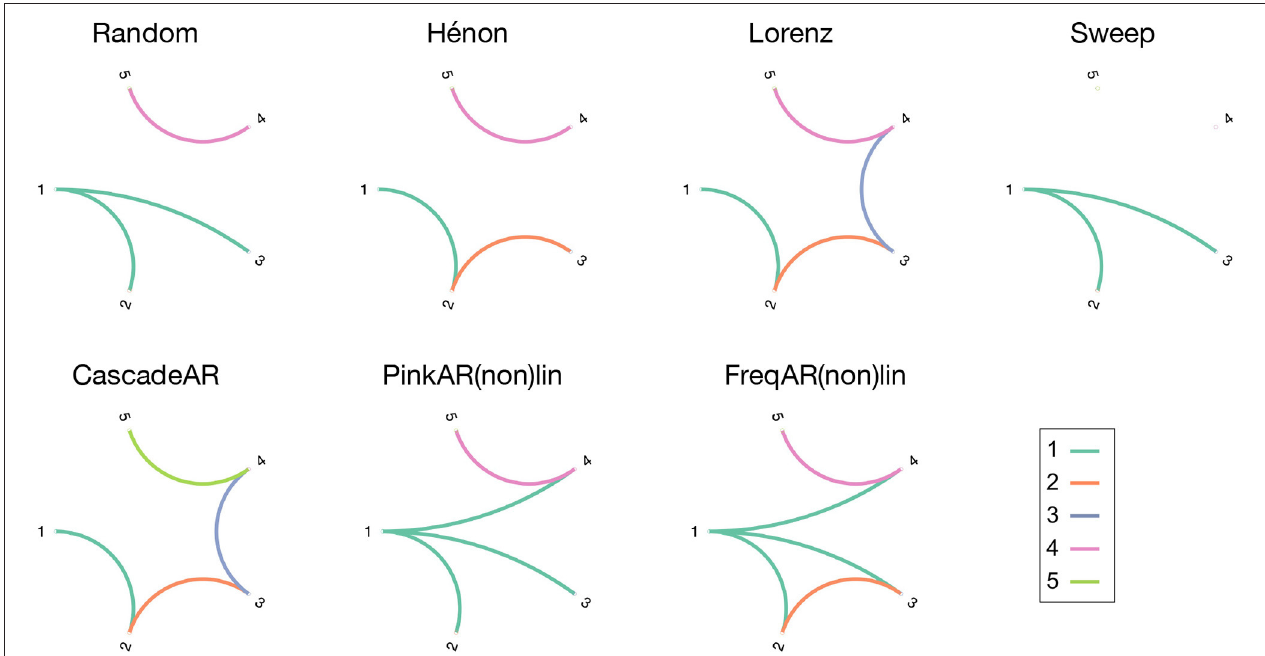
FIGURE 1 | Overview figure, showing the connection diagrams of the different simulation models that were used in this study. The connections are colour-coded in function of the source